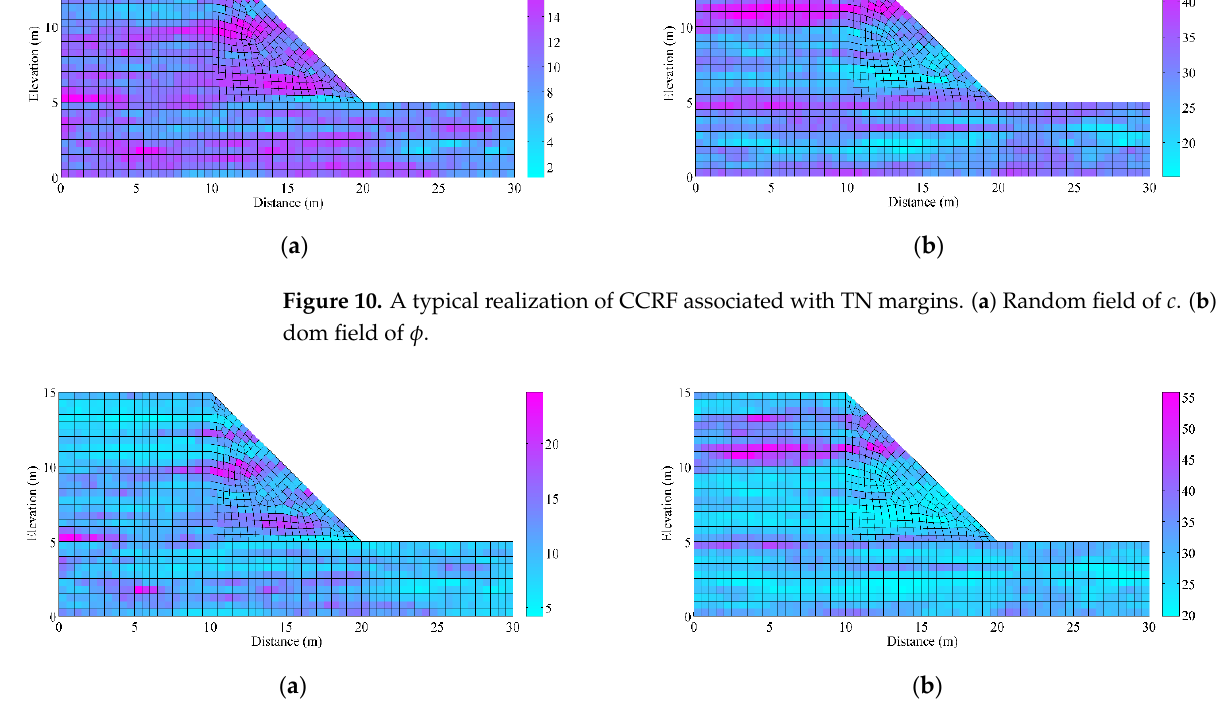
Figure 11. A typical realization of CCRF associated with TG margins. ( a ) Random field of c . ( b ) Random field of ϕ.